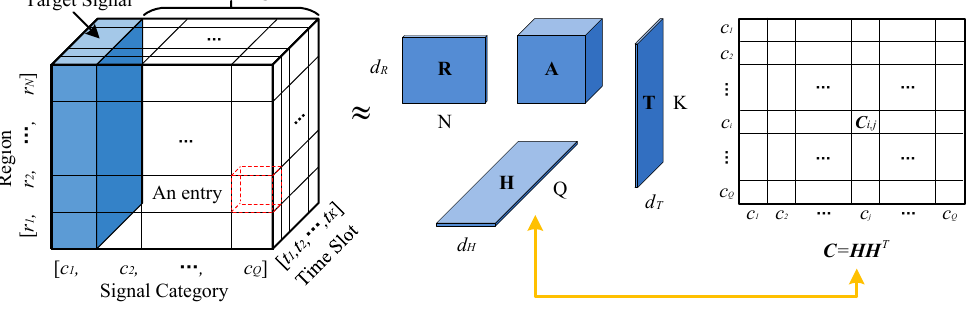
Figure 4. Collaborative tensor